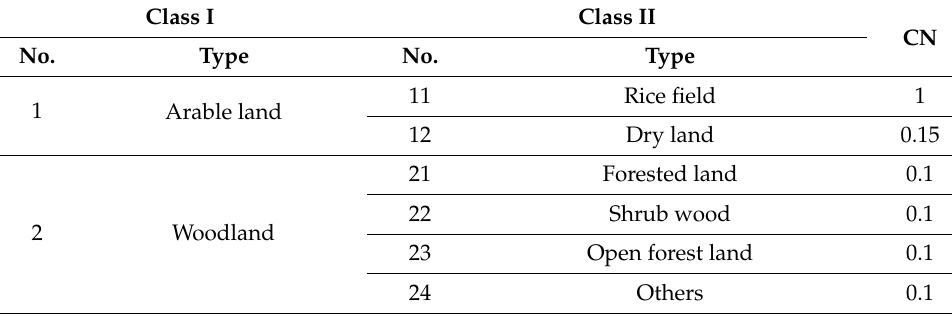
Table A2. Correspondence between land use types and